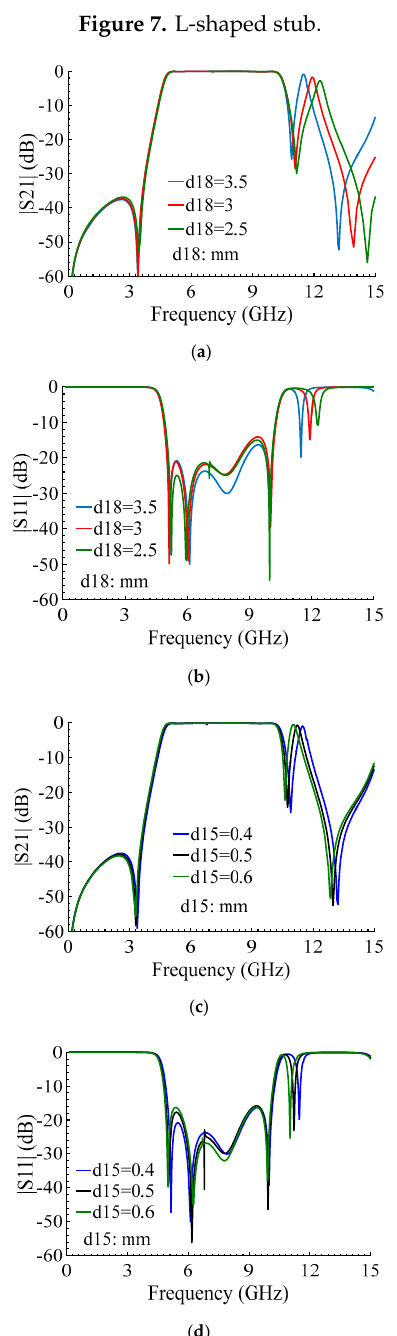
Figure 8. Adjustability of the second passband: ( a ) |S21| variations versus d18, ( b ) |S11| variations versus d18, ( c ) |S21| variations versus d15, ( d ) |S11| variations versus d15.